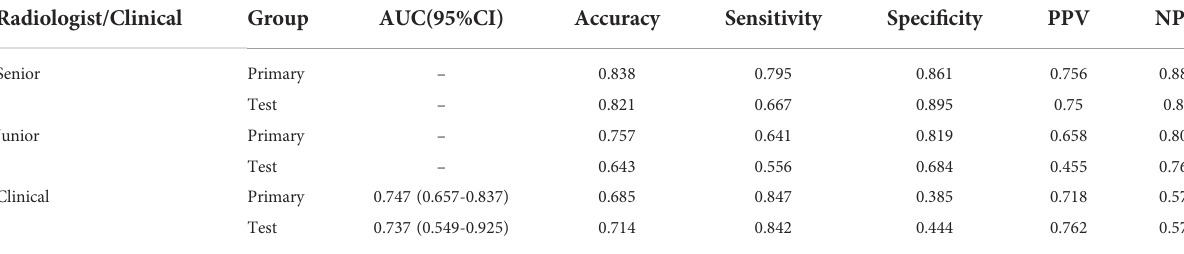
TABLE 4 The performance of radiologists and clinical model.